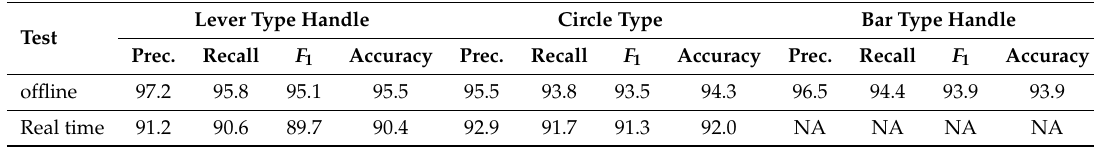
Table 1. Statistical measures for door-handle detection.